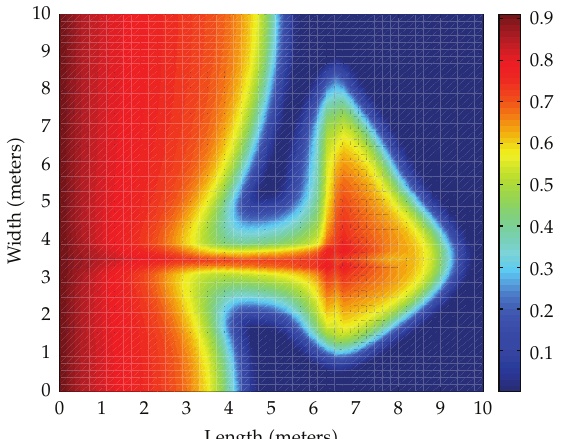
Figure 5: Water saturation profile at 0.45 PVI by the proposed method: Example 2.